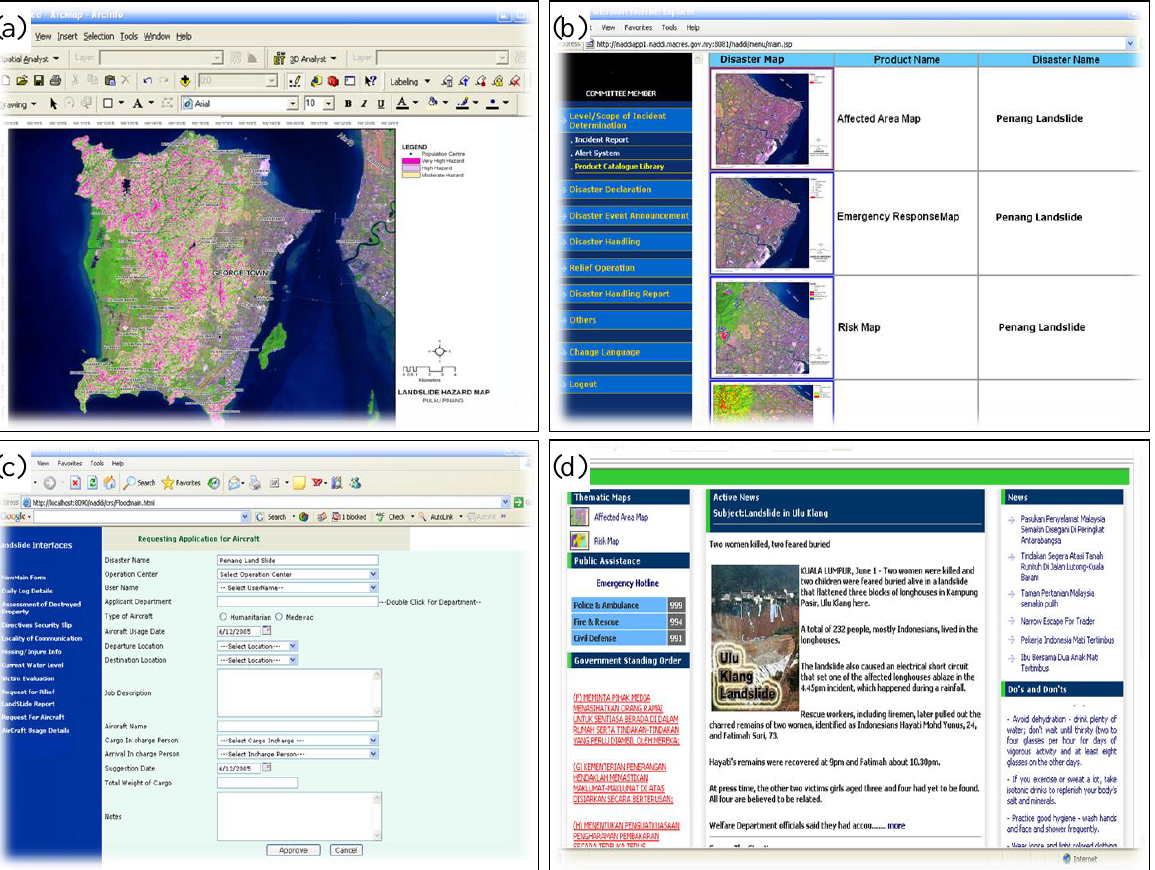
Figure 7. Key system functionalities include: (a) landslide disaster analysis in GIS, (b) Landslide disaster products in the Central Repository System ( CRS) (c) Command and Control and (d) Web